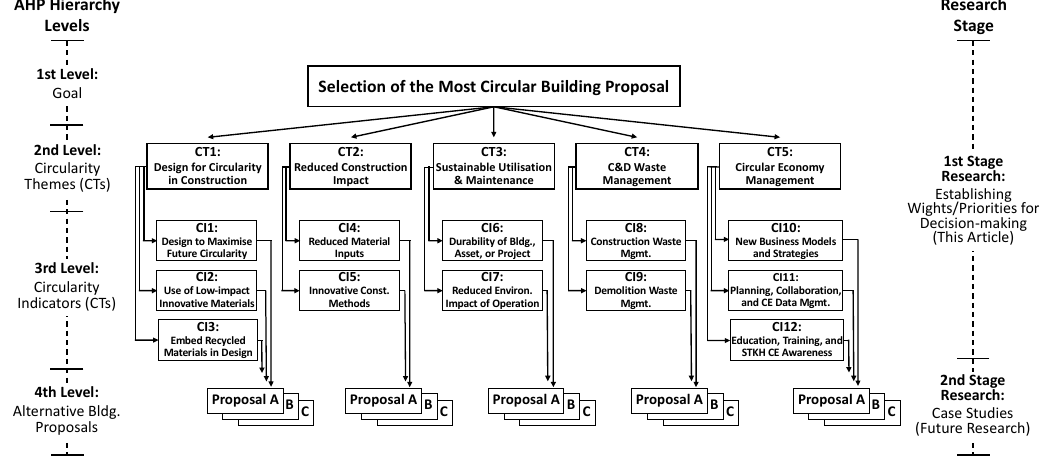
Selection of the Most Circular Building Proposal